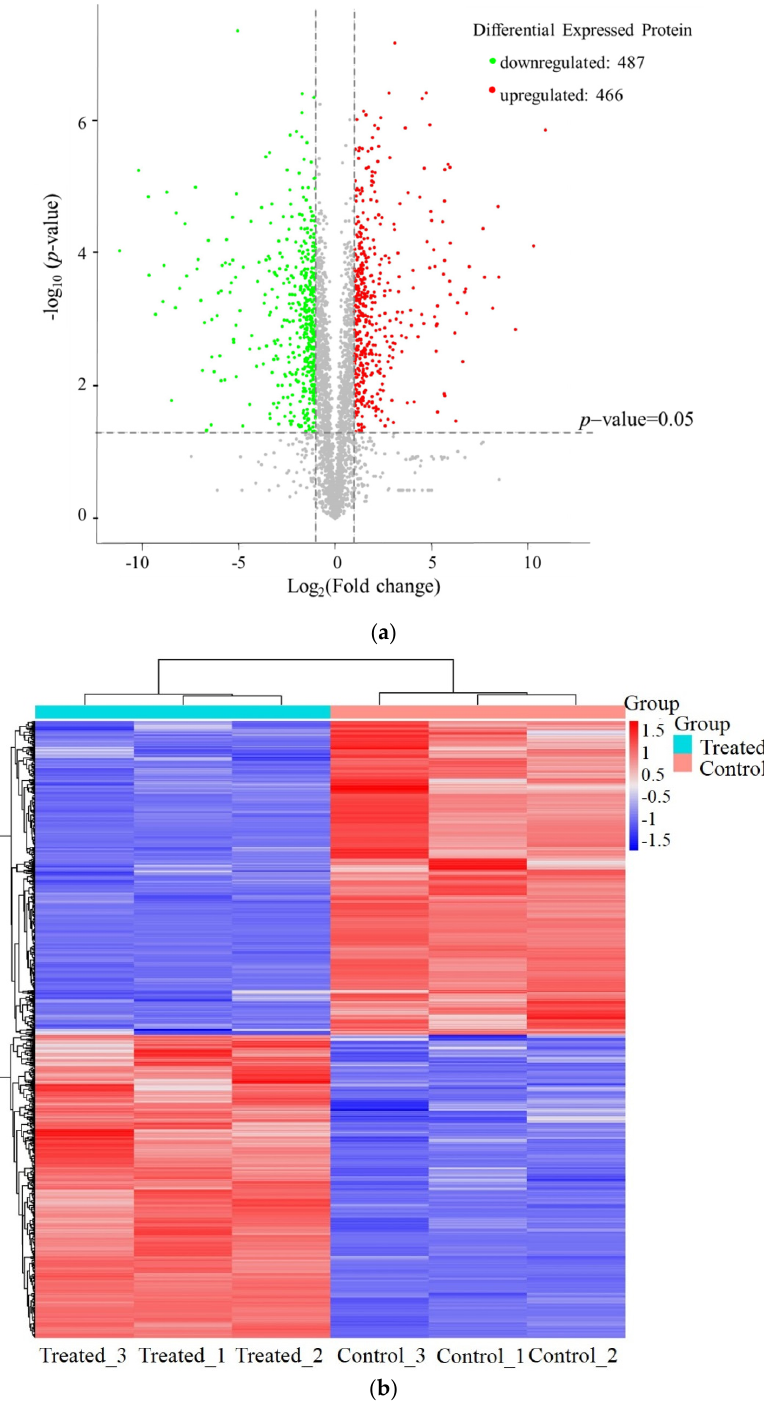
Figure 6. Label-free analysis reveals DEPs between the two groups. Volcano plot of the DEPs obtained from control and treatment samples, the red and green dots are considered to be differentially expressed proteins (DEPs) ( a ), The hierarchical clustering analysis ( b ).